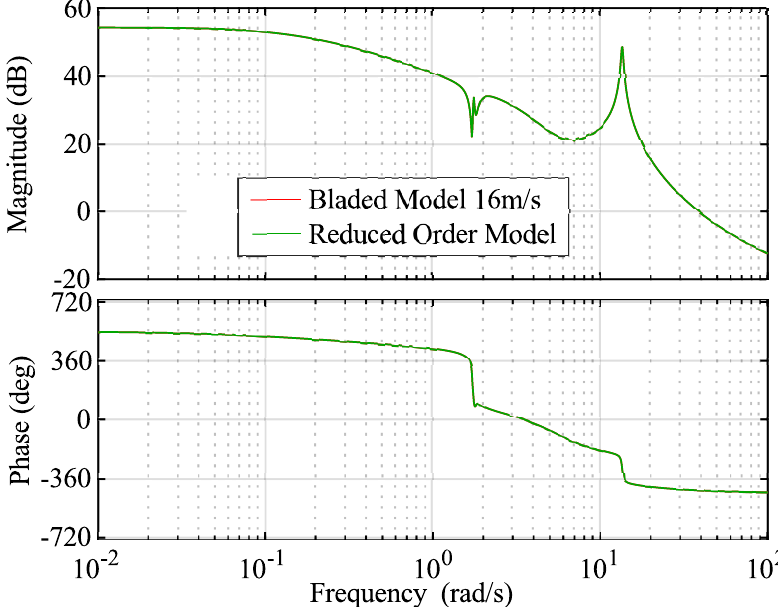
Figure 6. Frequency response of Bladed and reduced–order models in mode